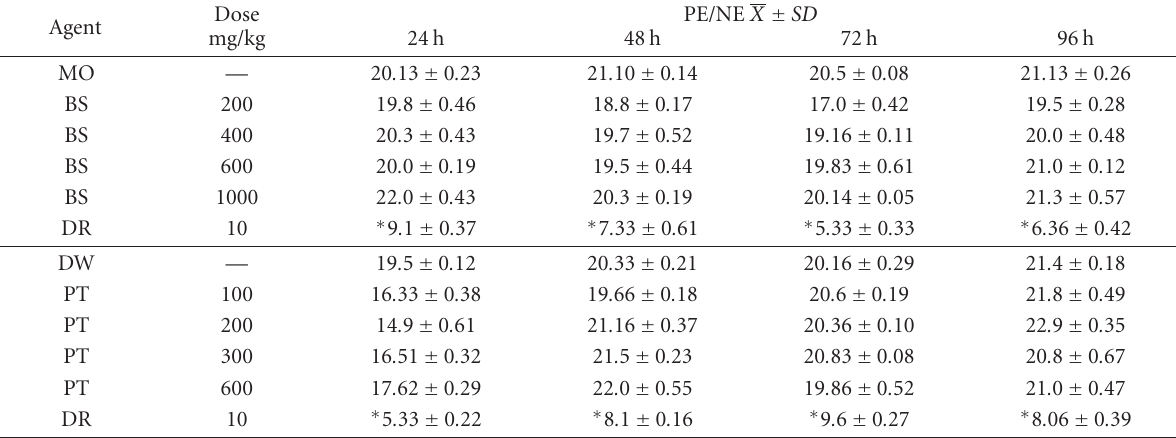
Table 3. E ff ect of beta-sitosterol (BS) and pteropodine (PT) in the index polychromatic erythrocytes/normochromatic erythrocytes (PE/NE) in mouse blood cells. MO = mineral oil (0.4 mL added to each mouse). DW = distilled water (0.4mL added to each mouse). DR =